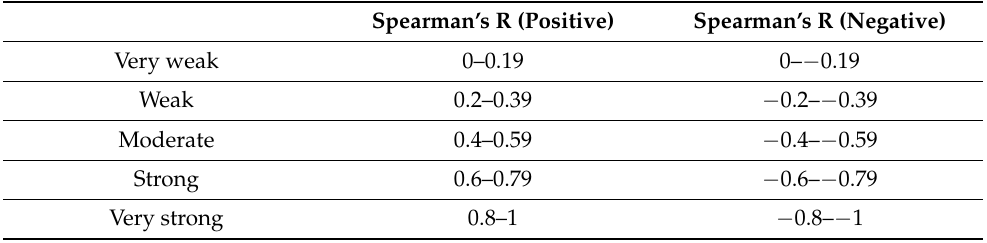
Table 2. Classification of correlation strength. Table summarising correlation